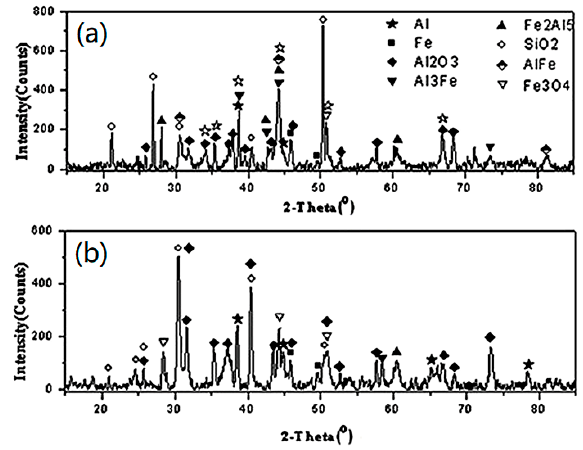
Figure 5. XRD patterns of the reaction products with different thickness targets: ( a ) 2-mm target; ( b ) 5-mm target. This picture is taken from “Li, Q.; Du, Y. Experimental Study on the Energy-Release Characteristics of Fine-Grained Fe/Al Energetic Jets under Impact Loading. Materials 2019 , 12 , 3317” [21].